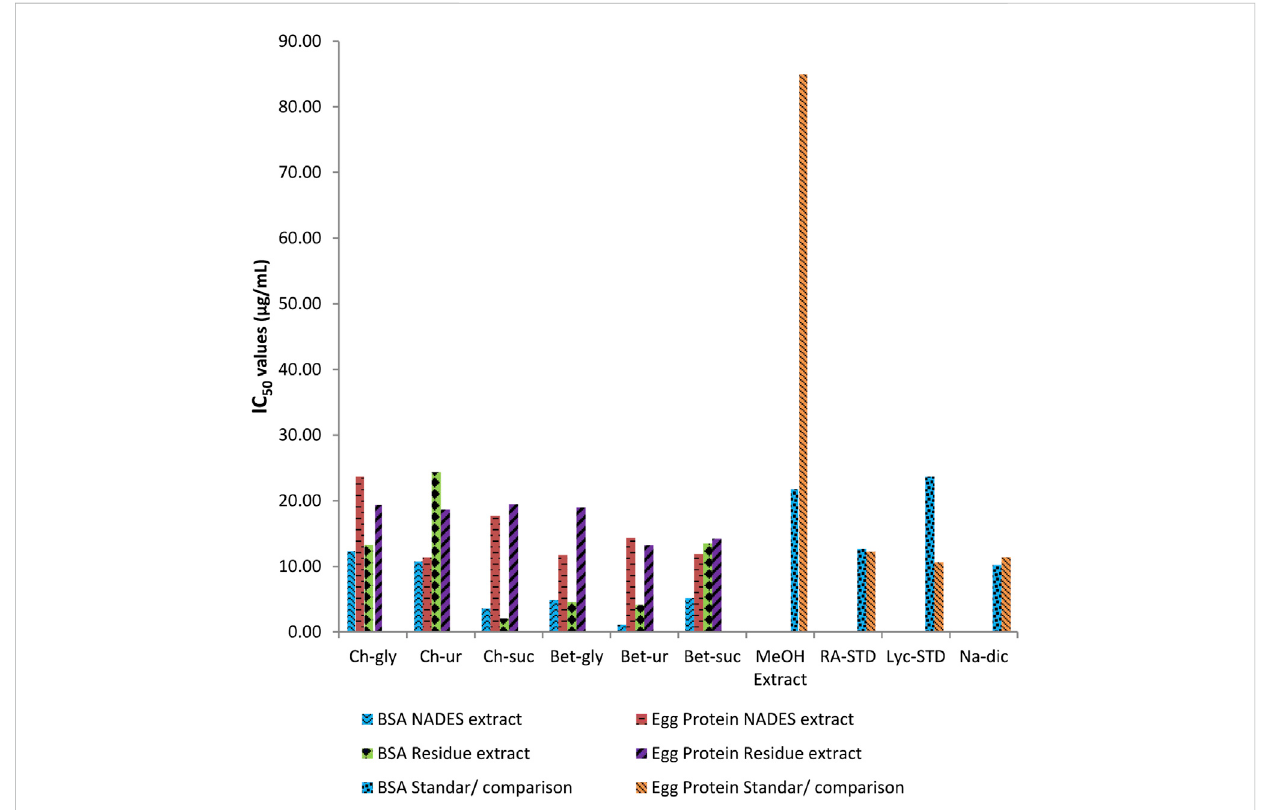
FIGURE 5 Comparison of anti-in fl ammatory activities of comfrey leaf extracts by different NADES and methanol, and those of standard metabolites.